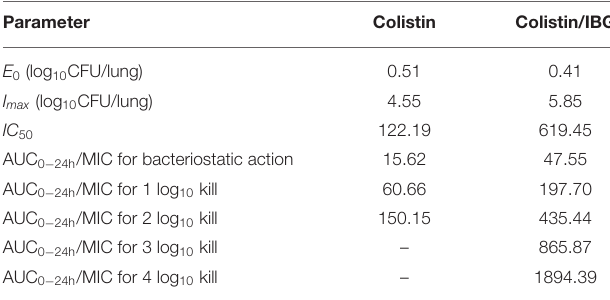
TABLE 3 | PK/PD parameter estimates for the AUC 0 − 24h /MIC index and